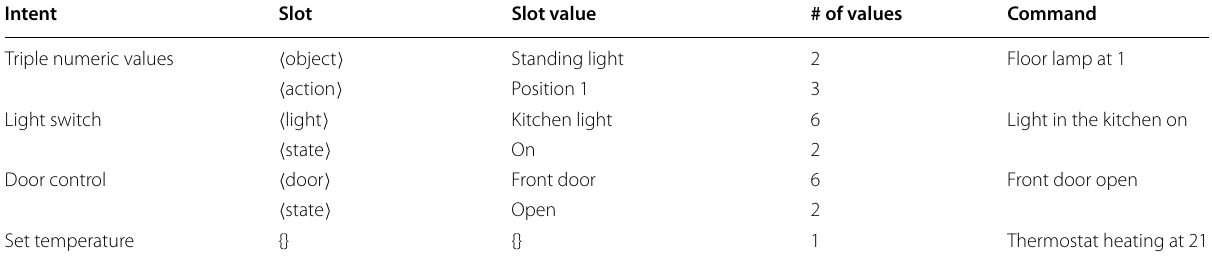
Table 2 Intent representations of Domotica samples